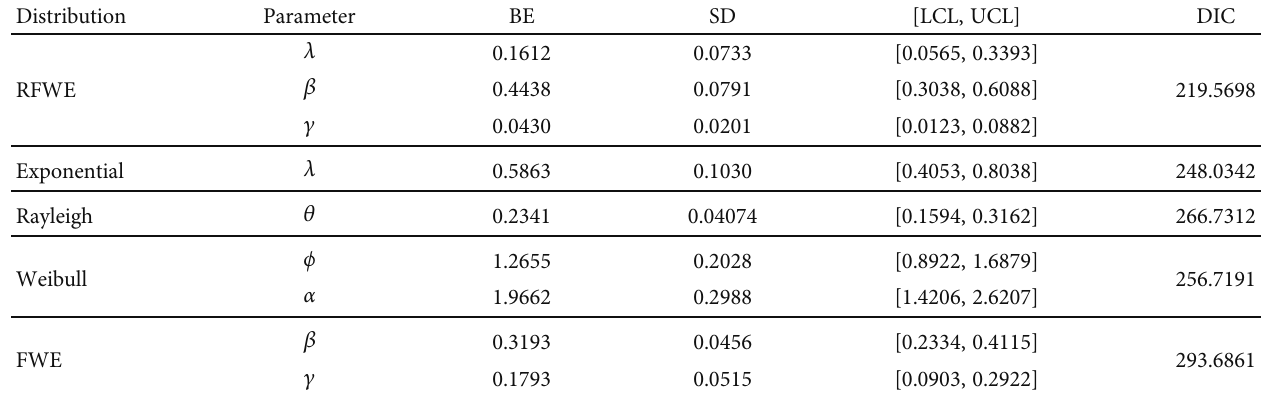
Table 5: Posterior results under uniform prior